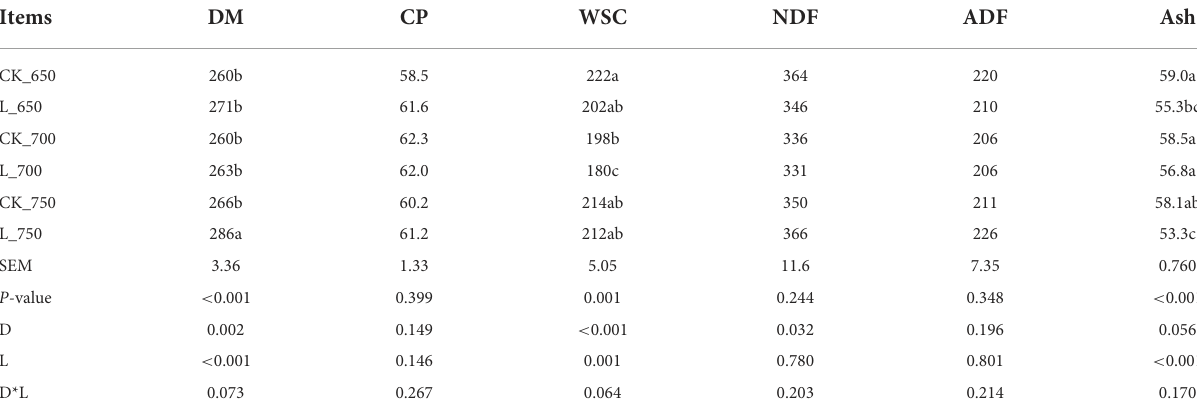
TABLE 6 Dry matter content (DM, g/kg) and nutritional compositions concentration (g/kg DM) in sweet sorghum silages ( n =